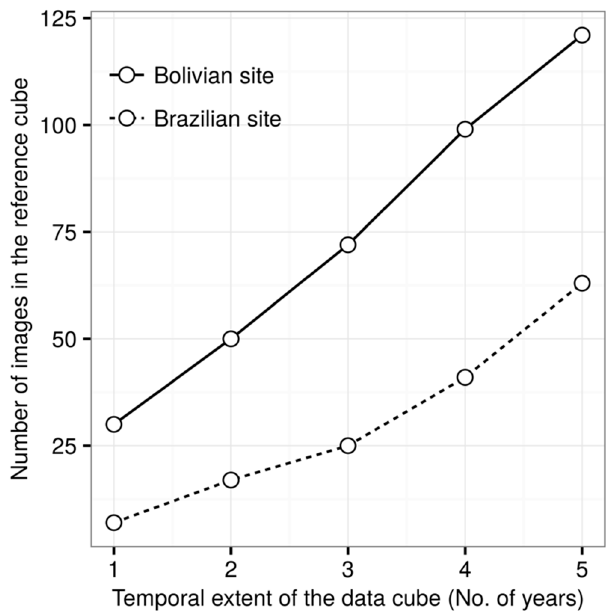
Figure 5. Cumulative number of images in the reference cube versus the temporal extent of the reference cube at Bolivian and Brazilian study sites.